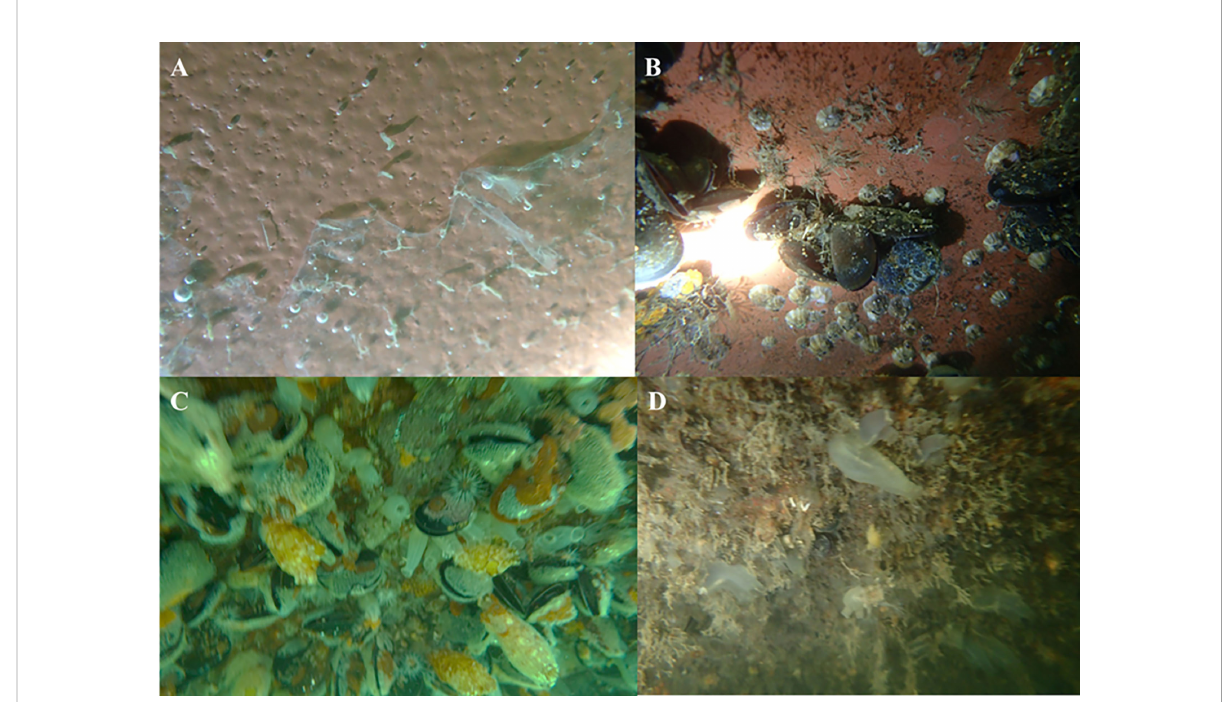
FIGURE 4 Resettlement photographs of the main fouling organisms including ascidians, mussels ,barnacles, etc. on the undersurfaces of Docks I and II over 3 years following their initial removal. (A) Some thin bio fi lms appeared on the undersurface of Dock I 1 month later. (B) A</ca> few macro- fouling organisms, such as Mytilus galloprovincialis and Balanus spp., appeared on the undersurface of Dock I after 2 years. (C) A</ca> large number of macro-fouling organisms including M. galloprovincialis , Styela spp., etc. settled on the undersurface of Dock I in the third year. (D) Many macro-fouling organisms (e.g., Ciona intestinalis ) resettled on the undersurface of Dock II 1 year later. To monitor the resettlement of A. coerulea polyps and other macro-fouling organisms on the undersurfaces of Docks I and II, 10-15 quadrats, each with an area of 600cm 2 , on the undersurface of the dock were chosen randomly and photographed via scuba diving using an Olympus waterproof camera in September. The number of A. coerulea polyps and other macro-fouling organisms in each quadrat image was counted. Their density on the undersurface of the dock was calculated from the average of the corresponding number divided by the area of each